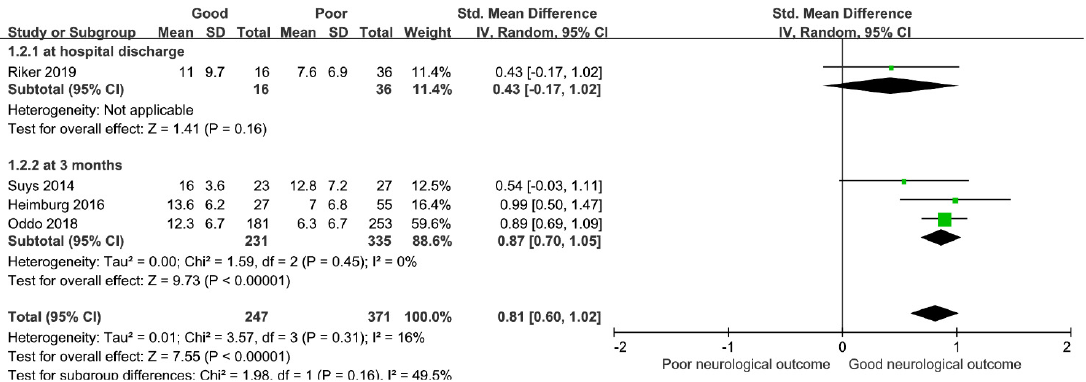
Figure 2. Forest plot for percent constriction of pupillary light reflex measured at 0–24 h after hospital admission and neurological outcome at hospital discharge and 3 months. CI, confidence interval; SD, standard deviation.